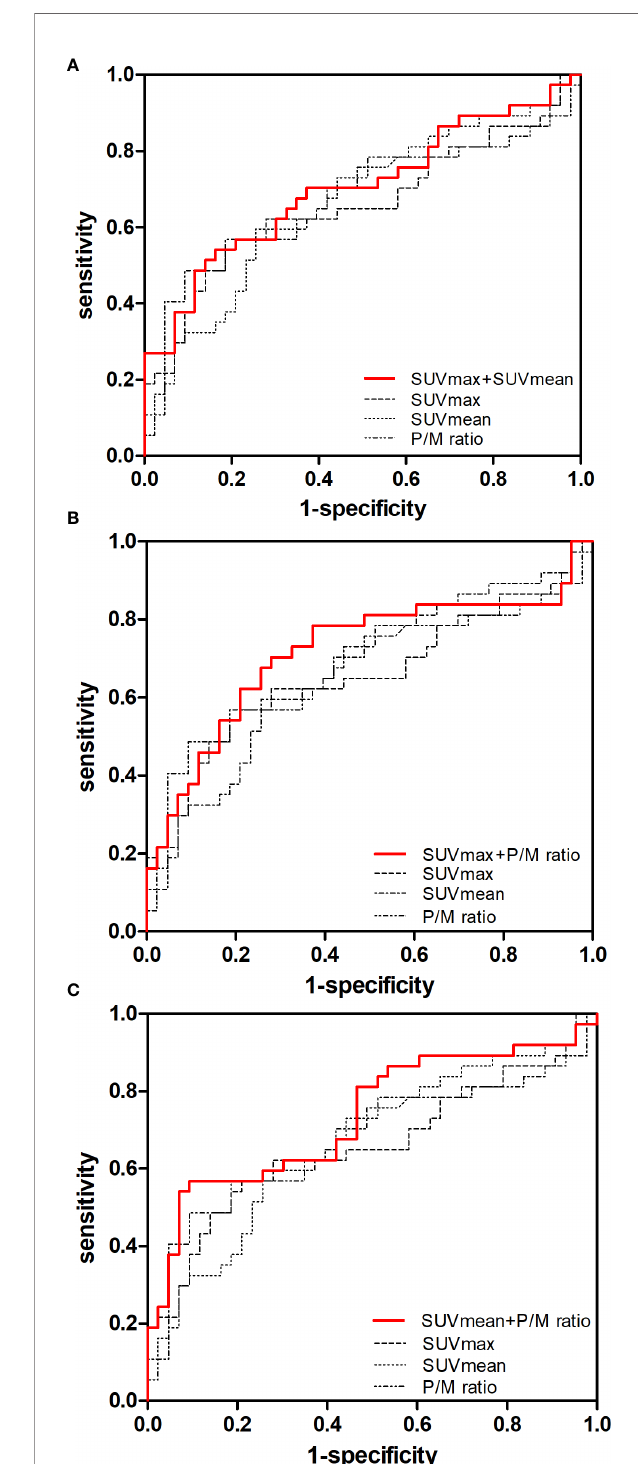
FIGURE 3 | Predictive value of single parameters and two-parameter combination in the diagnosis of early-stage PCa. ROC curves for (A) SUVmax, SUVmean and SUVmax + SUVmean, (B) SUVmax, P/M ratio and SUVmax + P/M ratio, (C) SUVmean, P/M ratio and SUVmean + P/M ratio in controls versus patients with early-stage PCa are